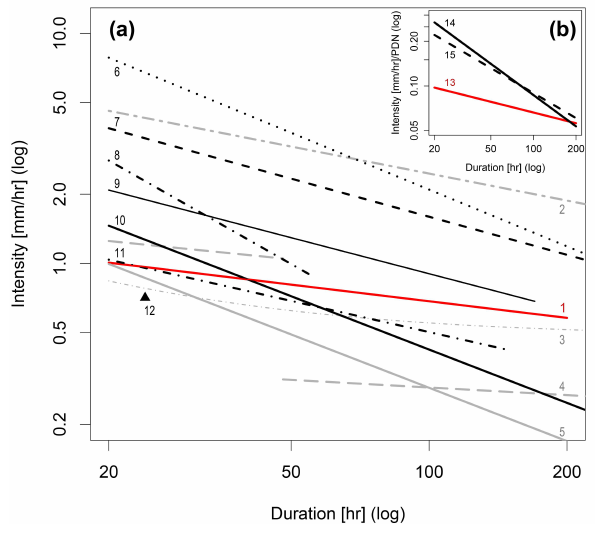
Fig. 9. The obtained absolute minimum threshold (1) and the ob- tained normalized minimum threshold (13) (both red) in com- parison to a selection of other global (gray), regional and local (black) minimum ID thresholds. References for absolute thresholds in (a) : Caine (1980) (2); Clarizia et al. (1996) (3); Crosta and Frat- tini (2001) (4); Guzetti et al. (2008) (5); Larsen and Simon (2003) for Puerto Rico (6); Ceriani et al. (1992) for Lombardy, Italy (7); Baum et al. (2005) for Seattle Area, US (8); Jakob and Weath- erly (2003) (9), Moser and Hohensinn 1983 for Eastern Tyrol, Aus- tria (10); Montgomery et al. (2000) for Oregon, US (11); Cepeda et al. (2010) for Norangselva, Western Norway (12). Reference for normalized thresholds in (b) : Guzzetti et al. (2007) for mild cli- mates (14) and Guzzetti et al. (2007) for highlands (15). Note that durations are given in hours